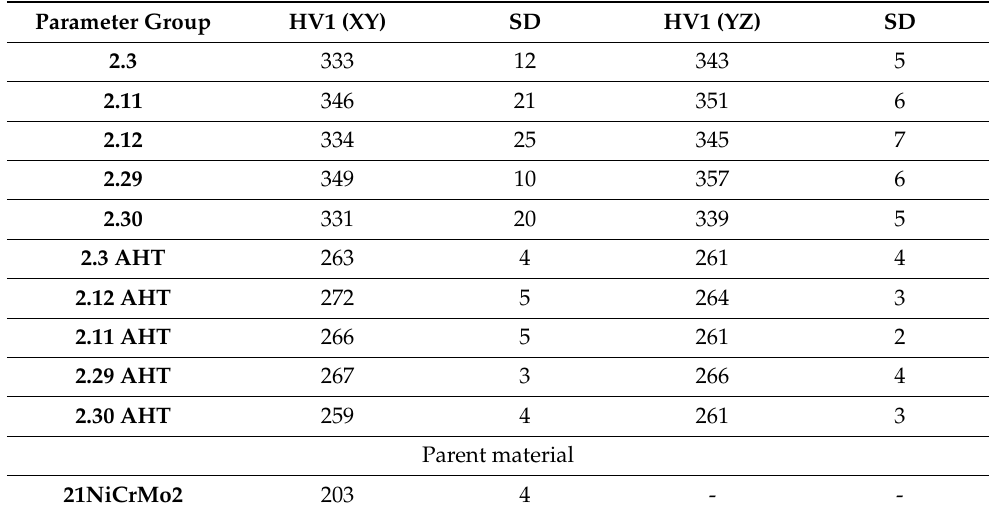
Table 7. HV1 hardness measurements of the parent material and PBF-LB/M (as-built and AHT) material. Parameter Group HV1